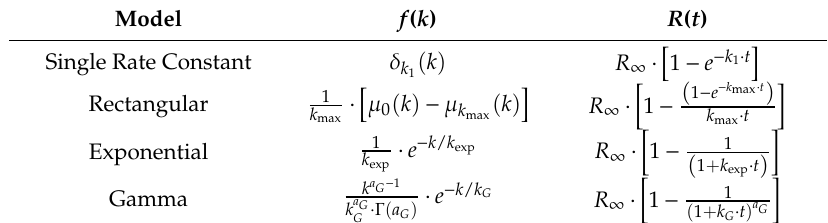
Table 1. Some flotation rate distributions and the respective recoveries in batch flotation processes. Model f ( k ) R ( t